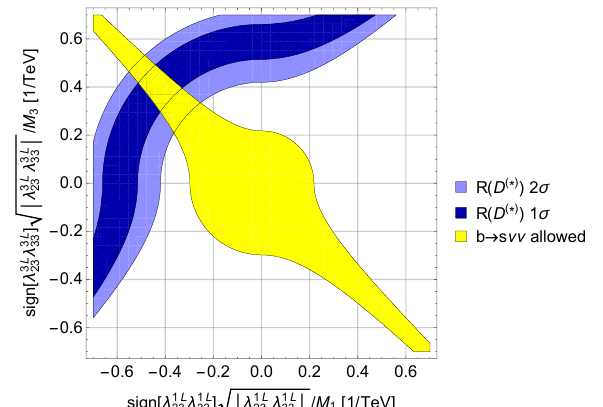
Figure 4 . Allowed regions for R ( D ( (cid:3) ) ) and b for the leptquark singlet and triplet. Here M